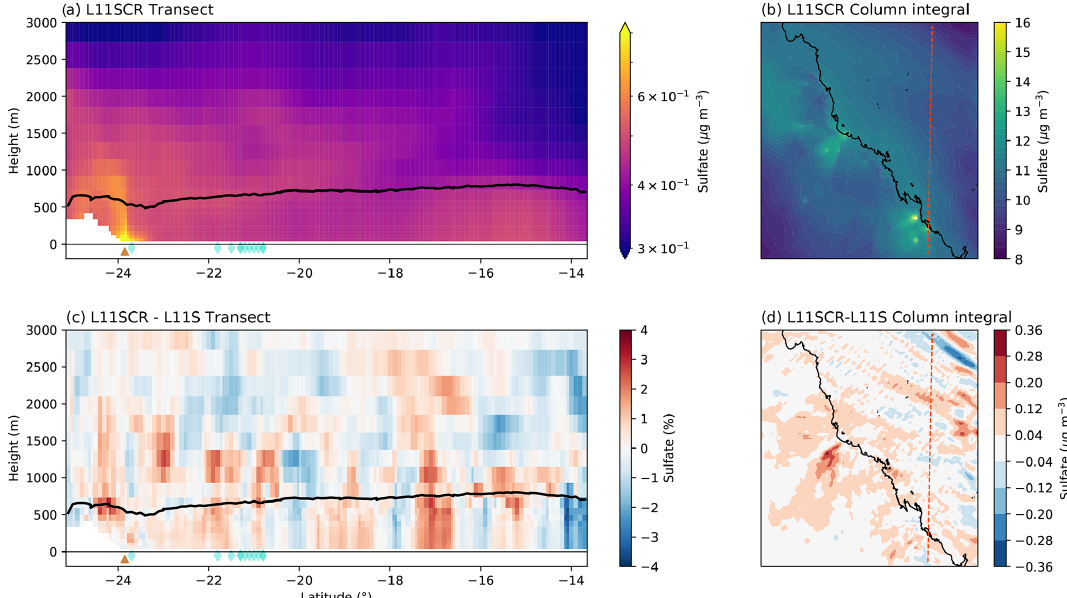
Figure 6. As for Fig. 5 but for total sulfate aerosol